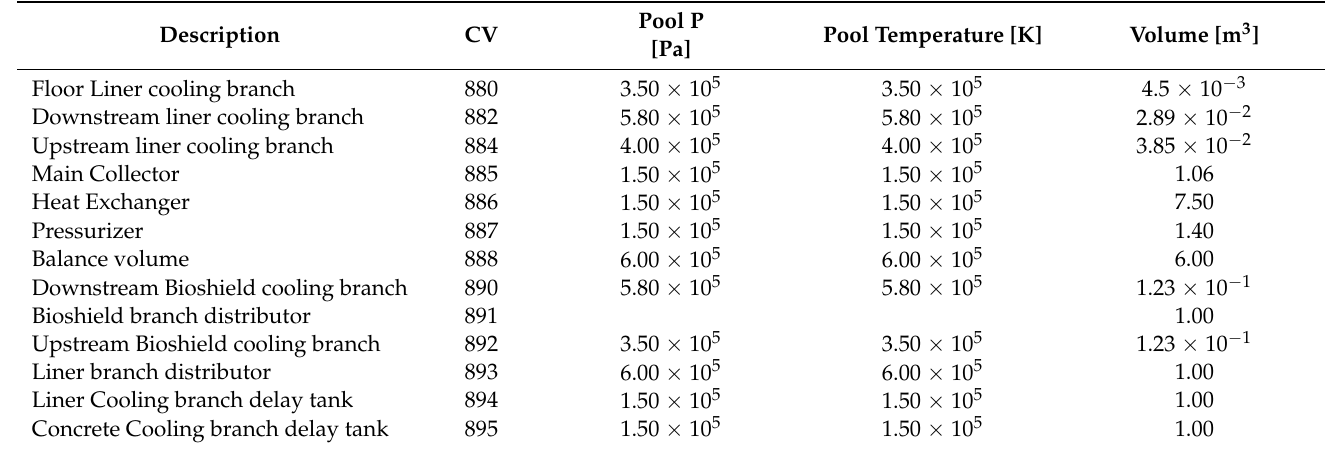
Table 3. Control Volumes in the TC-WCS loop.